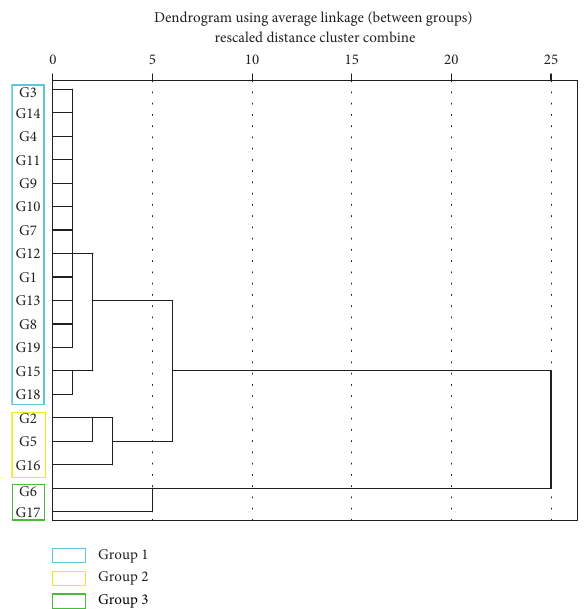
Figure 4: Cluster analysis results of sediment sampling points in the Guanting Reservoir. Table 4: Average values of sterols of three groups of sampling points in the Guanting Reservoir based on the cluster analysis ( μ g g − 1